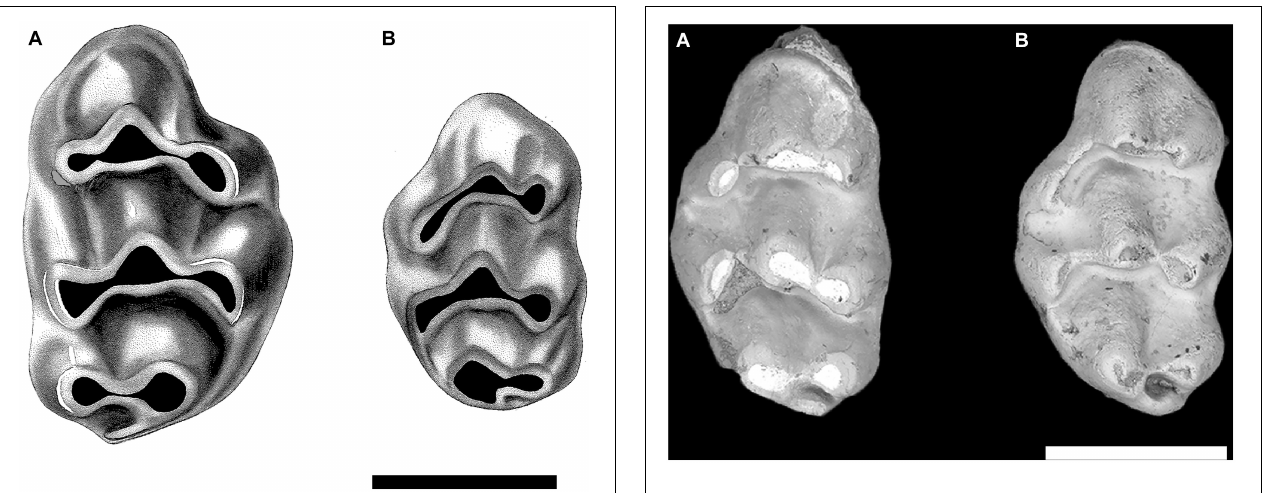
FIGURE 6 | Indeterminate Karnimata – Progonomys grade molars from locality Y797, 11.2 Ma. (A) Karnimata -like left M1 YGSP 36826 and (B) Progonomys -like left M1 YGSP 33878. Both at same 1 mm scale, anterior is